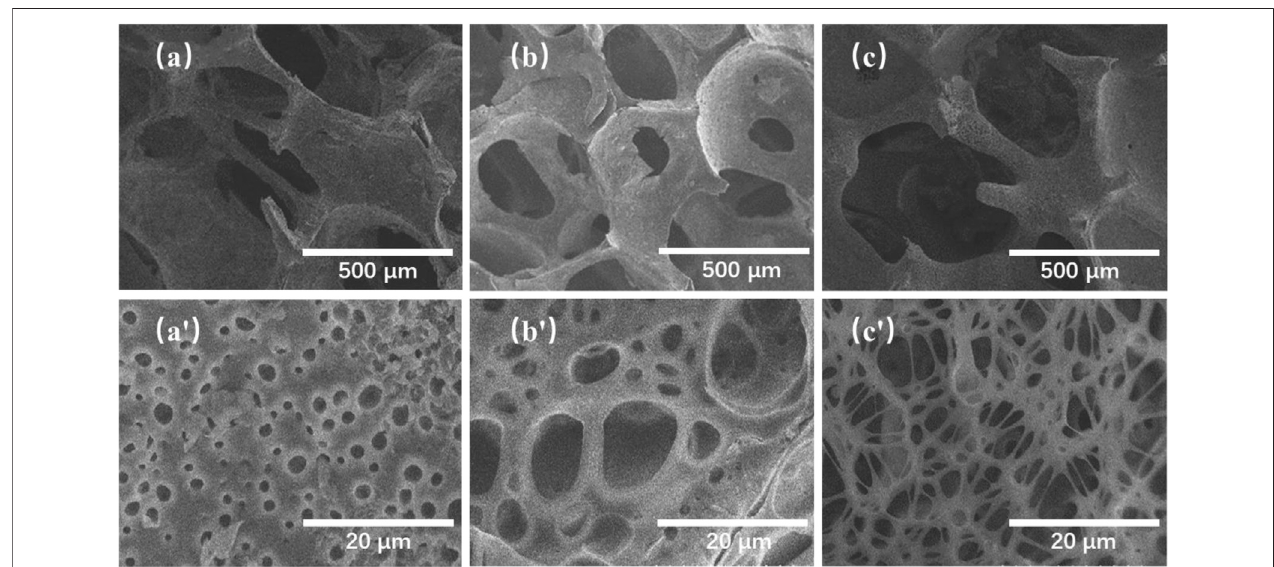
FIGURE 1 | SEM images of TMBG scaffolds before and after being coated with PDTEC: (A , A 9 ) TMBG, (B, B 9 ) TMBG-PDTEC8, and (C, C 9 ) TMBG-PDTEC16 scaffolds.